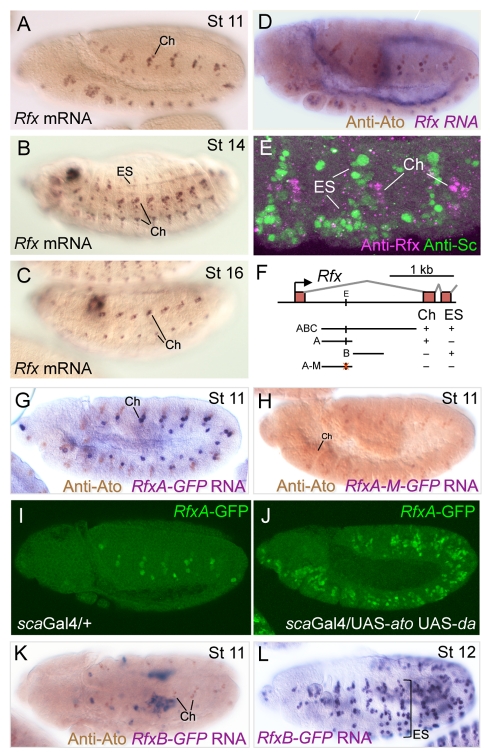

Rfx is a Ch-enriched gene that is directly regulated by ato.(A–C) Rfx is expressed in a ‘Ch-enriched’ pattern despite being required for both Ch and ES ciliary differentiation. (A) Early in neurogenesis, Rfx protein is present in Ch precursors but not ES precursors. (B) Later expression is strong in Ch lineages and weak in ES lineages. (C) During differentiation, Rfx protein is largely confined to Ch neurons. (D) Co-expression of Rfx mRNA and ato protein in Ch precursor cells. (E) Three segments from embryo stained to detect Rfx (magenta) and sc (green) proteins. There is no expression of Rfx in sc-expressing ES precursor cells. (F) Schematic of first three exons of Rfx gene, showing the location of separate Ch and ES enhancers; the tested E box is indicated (‘E’); lines indicate fragments tested in GFP reporter assay, with a summary of their expression. (G) GFP driven by RfxA enhancer is expressed early in Ch lineages. GFP mRNA is coexpressed with ato protein. (H) Mutation of an EATO box in RfxA abolishes the early Ch expression of GFP; Ch cells are marked by ato expression. (I,J) RfxA-GFP is ectopically expressed in response to ato misexpression. (I) Expression of RfxA-GFP in scaGal4 driver background (wild type). (J) Ectopic expression of RfxA-GFP in embryo in which ato protein and its dimerisation partner, daughterless (da), are jointly misexpressed in the ectoderm. (It has been shown that proneural factor activity in embryos is limited by da levels such that misexpression of a proneural factor alone has little effect [53]). (K,L) GFP driven by RfxB is not expressed at stage 11 (when ES and Ch precursors are present) (K) but is expressed later in ES lineages (L). We note that the RfxB enhancer also contains an EATO motif even though the enhancer is not active in Ch lineages; however, we cannot rule out the possibility that this motif is a functional ATO binding site in the context of the intact Rfx locus.